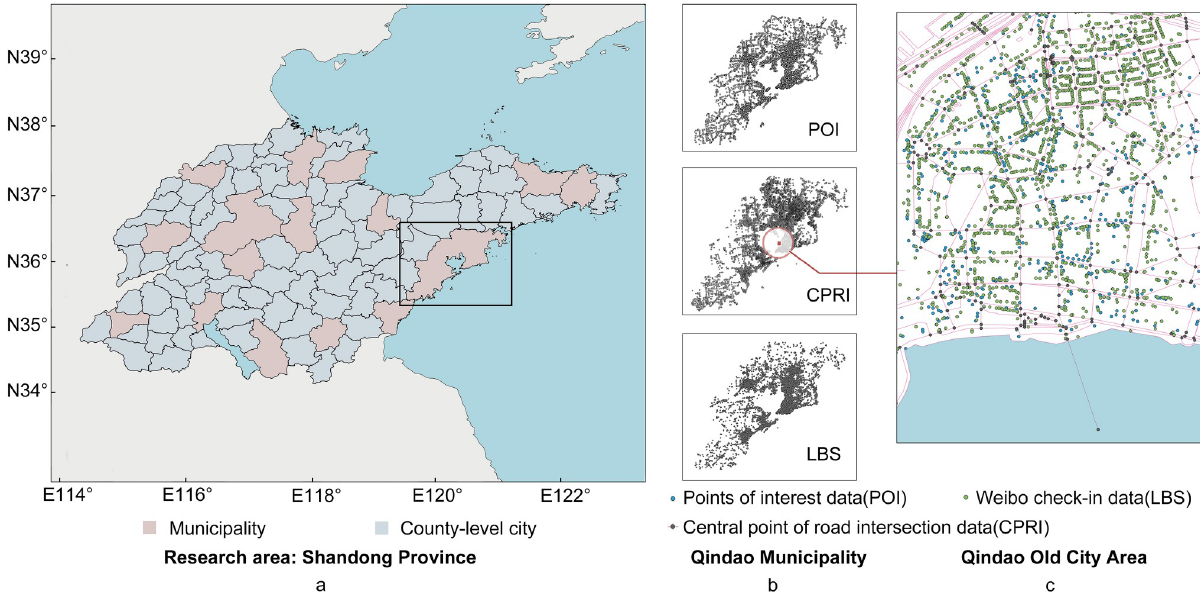
Fig 1. Visualization of the datasets used in this study. a) The division of Shandong province into 95 cities; b) Spatial pattern of three types of datasets of Qingdao; c) Spatial pattern of all the datasets of Qingdao. © OpenStreetMap [18] contributors.